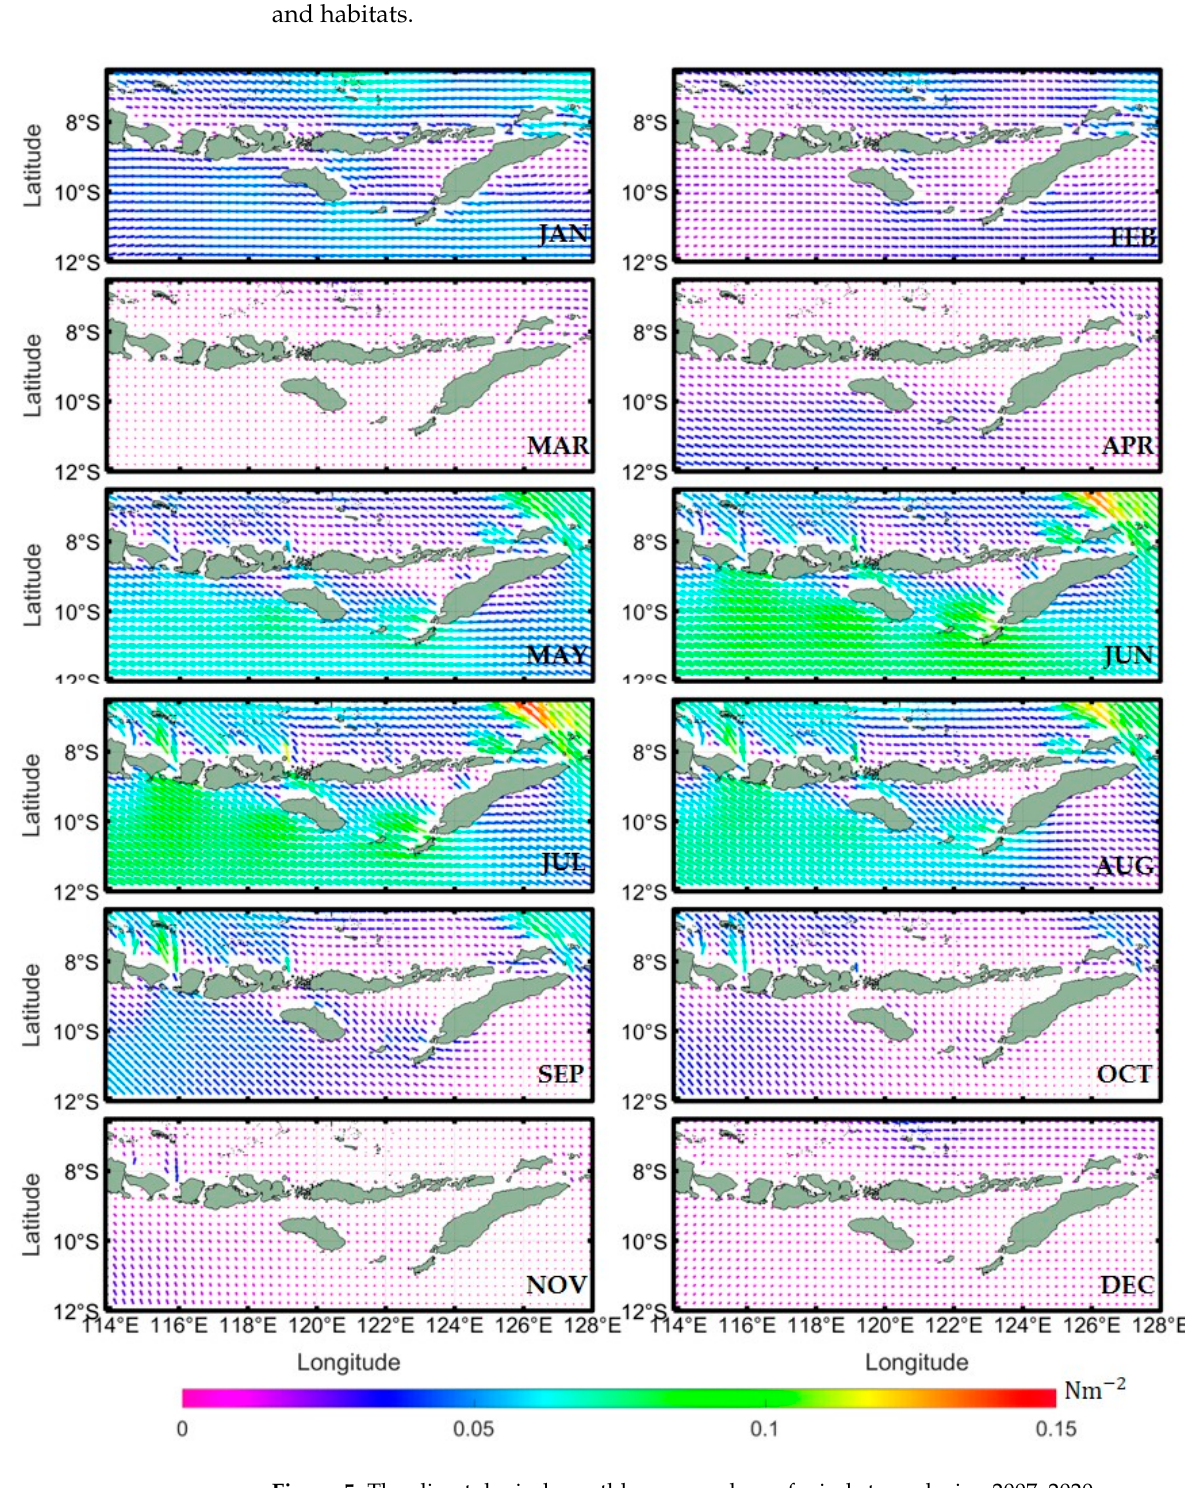
Figure 5. The climatological monthly mean values of wind stress during